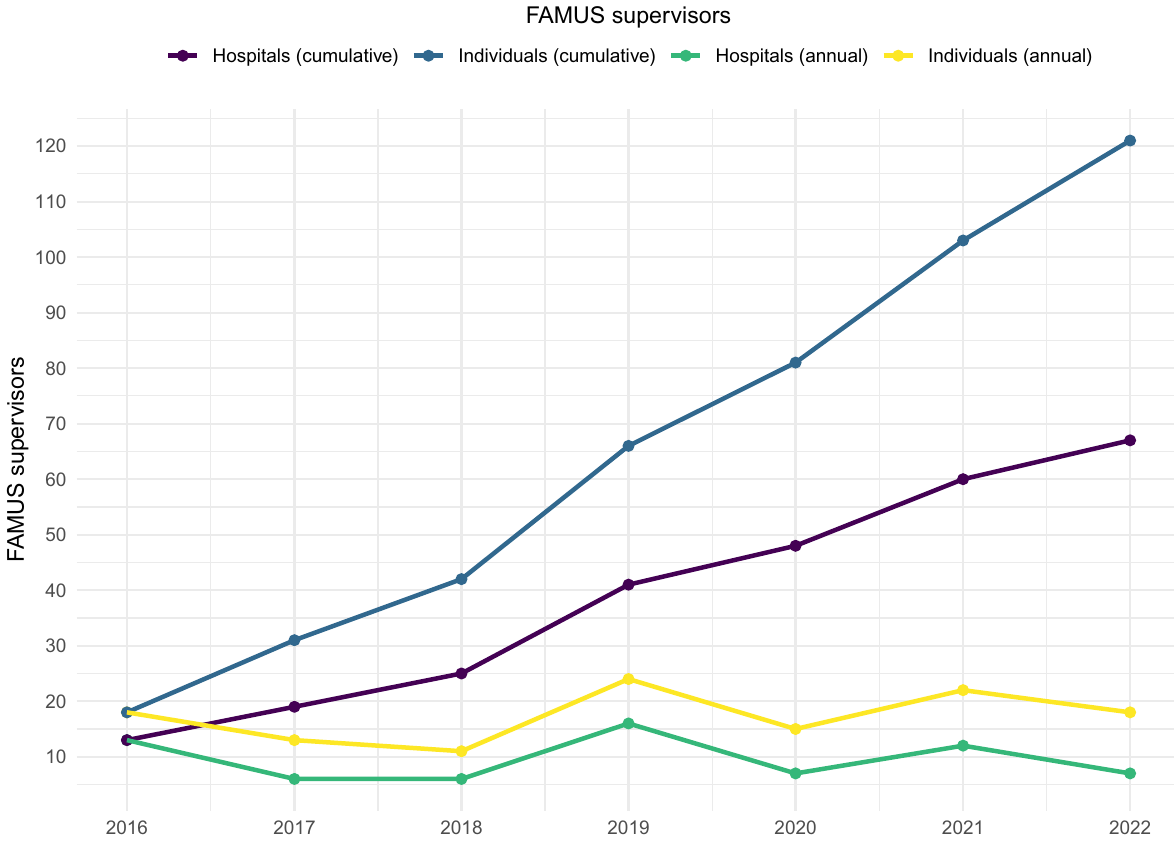
Fig. 4 Annual and cumulative growth rate of FAMUS supervisors aggregated at the national level and hospital